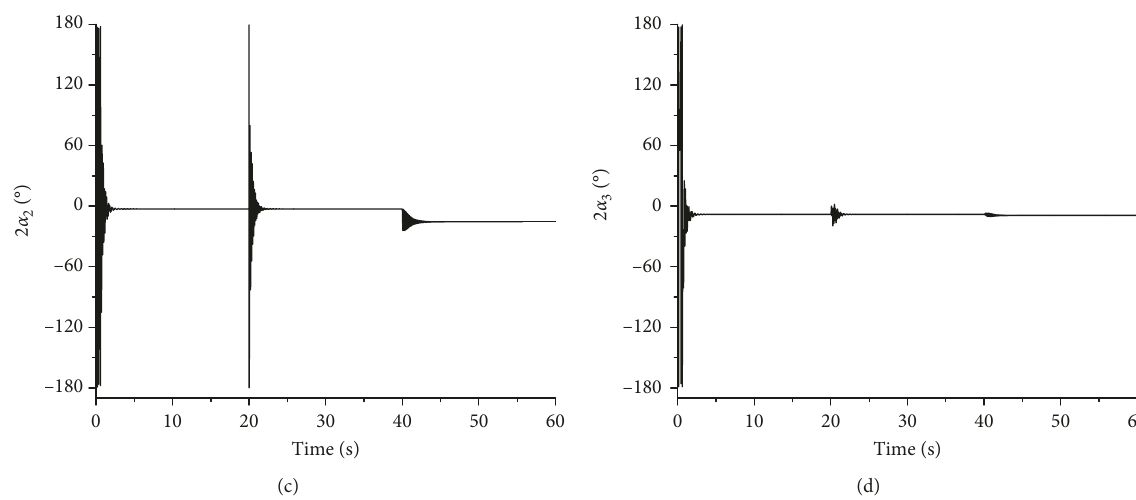
Table 3: The stable phase differences for η Simulation of point A Characteristic